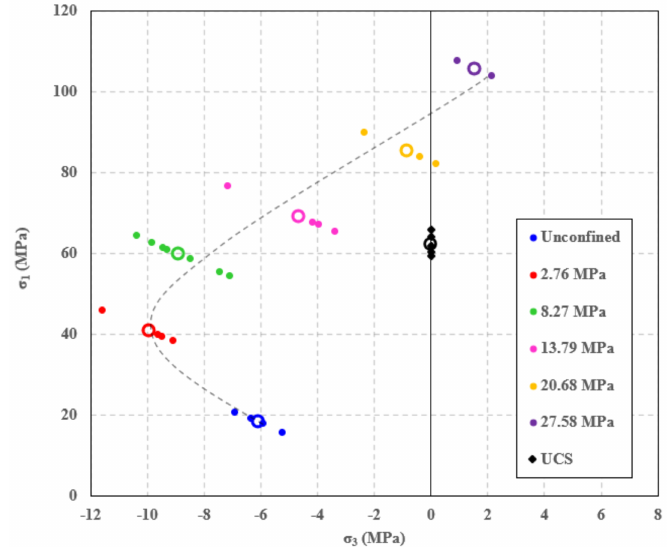
Figure 5. Minimum and maximum principal stresses at failure for a series of confined, flattened Brazilian disks on sandstone. Average values at each confining stress, including unconfined, are represented by an open point. Uniaxial compression strength (UCS) on the same sandstone is also shown. The dashed line represents the best fit failure